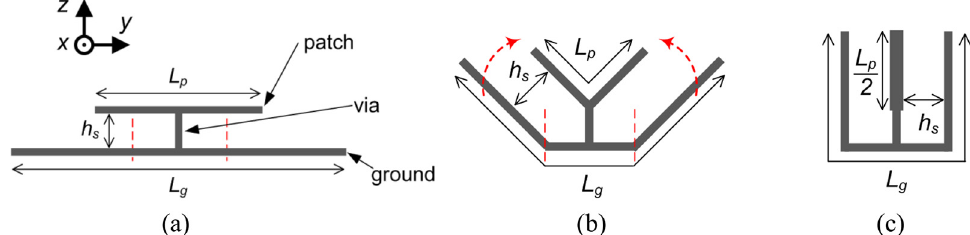
Fig. 6. Folding procedure (side view) (a) conventional mushroom antenna, (b) transforming stage, and (c) folded mushroom antenna [19].